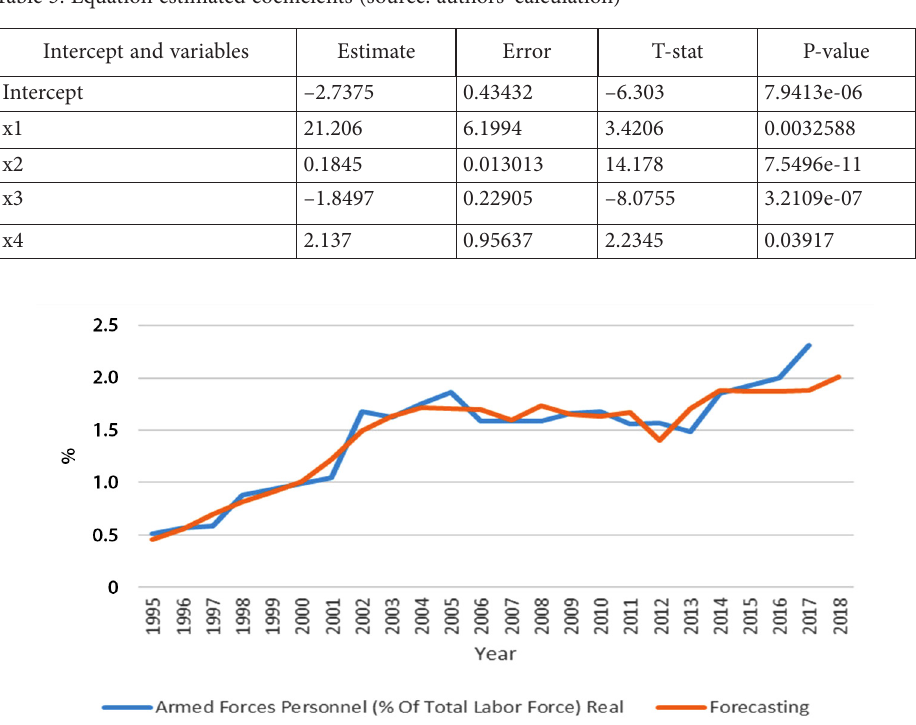
Figure 2. Comparison of dynamic of real Armed Forces Personnel and forecast by (1) regression equation (source: authors’ calculation)